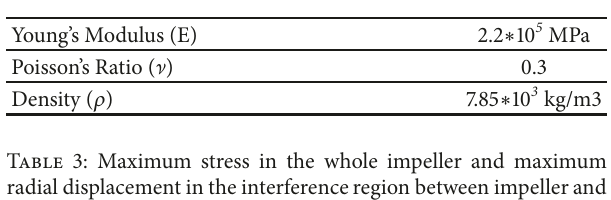
Table 2: Material Properties.